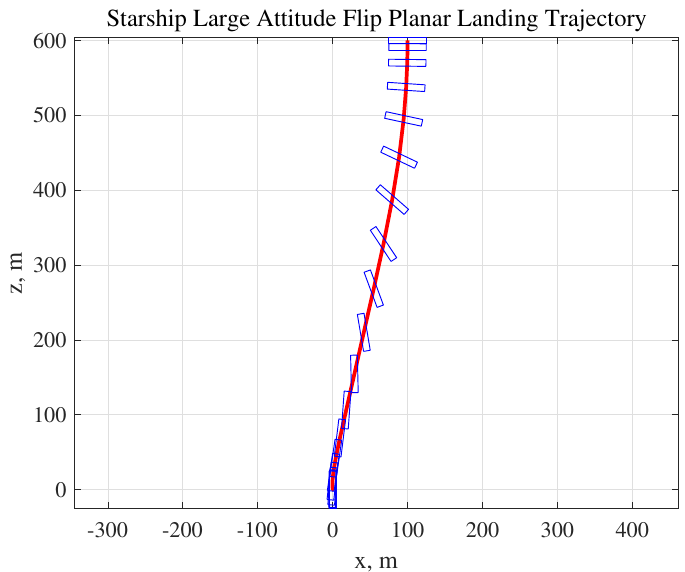
Figure 5. Starship large attitude flip planar landing